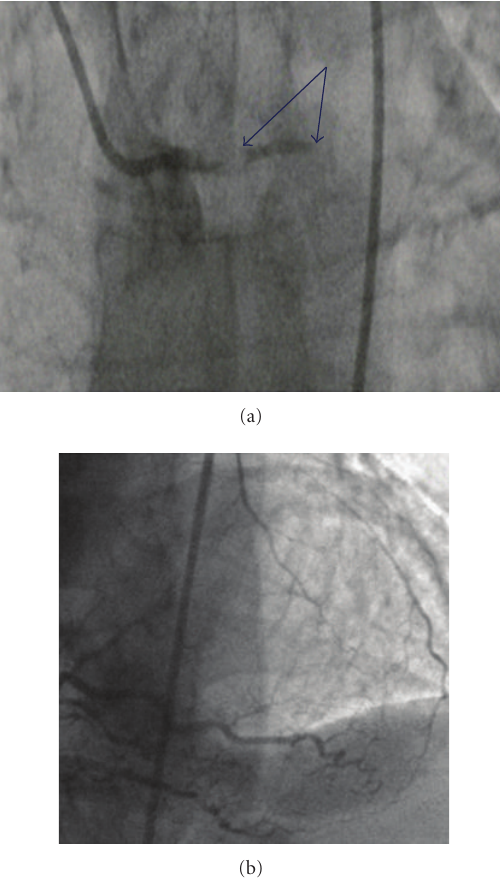
Figure 2: (a): Thrombotic occlusion of Left main coronary artery; (b): distal right coronary artery with collateral supply to left coronary system.